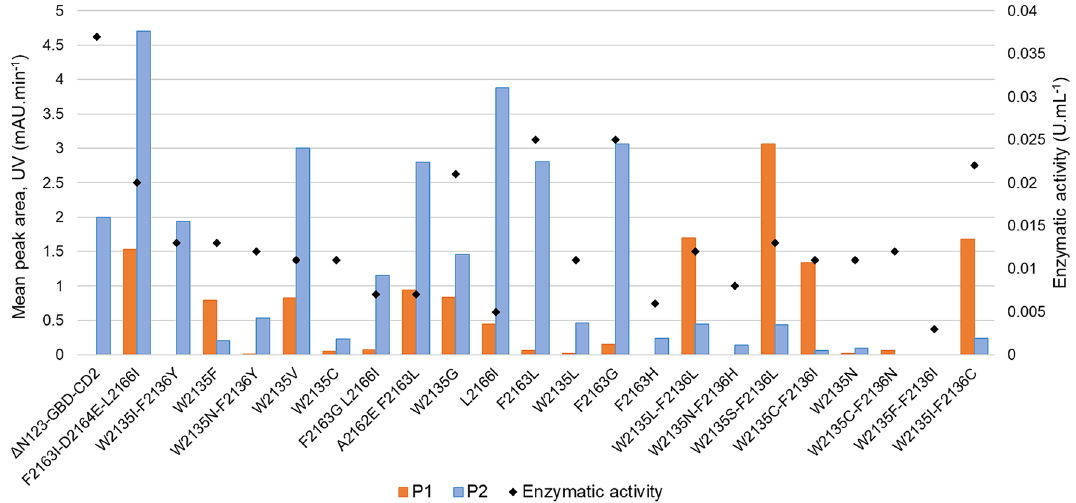
Figure 1. Amounts of products P1 (orange) and P2 (blue) formed with ΔN 123 -GBD-CD2 branching sucrase and its mutants in screening conditions. Reactions were carried out in 10 µL volume with 1 M sucrose and 50 mM ABC ′ D ′ for 16 h at pH 4.7 and 30 °C, using between 0.003 and 0.037 U mL −1 enzymatic activity (black diamonds). Quantities were estimated from mean peak areas obtained by HPLC–UV analysis at 220